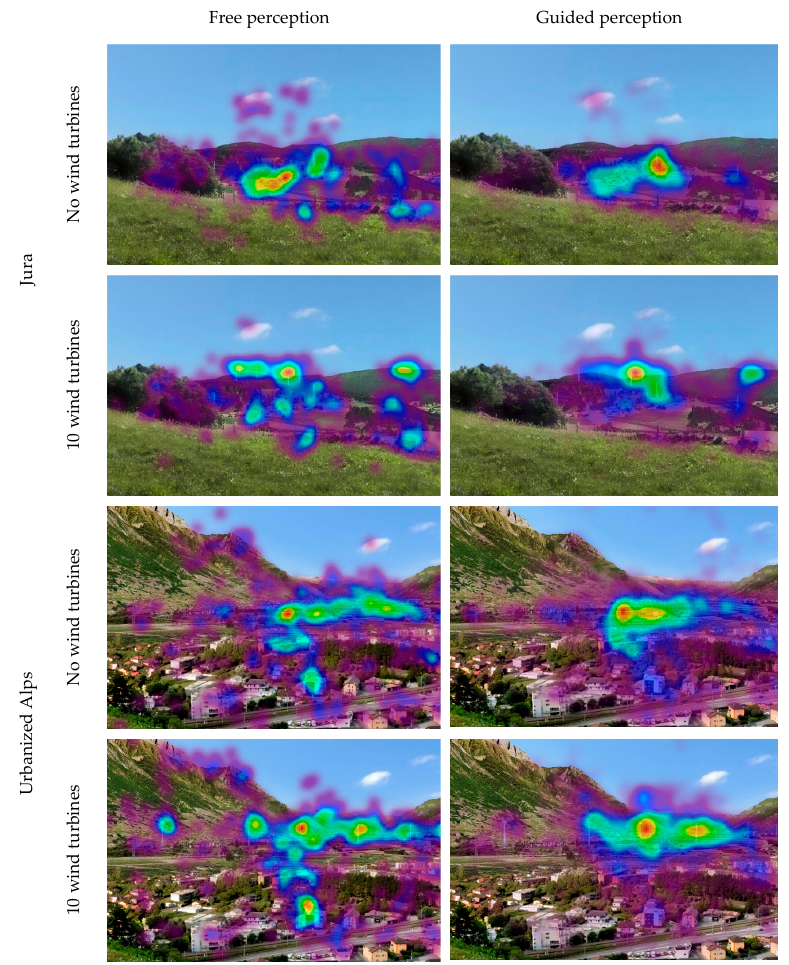
Figure 4. Attention heat maps for the landscape scenes of the “Jura” and the “urbanized Alps” perceived in the first ten seconds (free perception) and during the guided perception without wind turbines and with ten wind turbines.